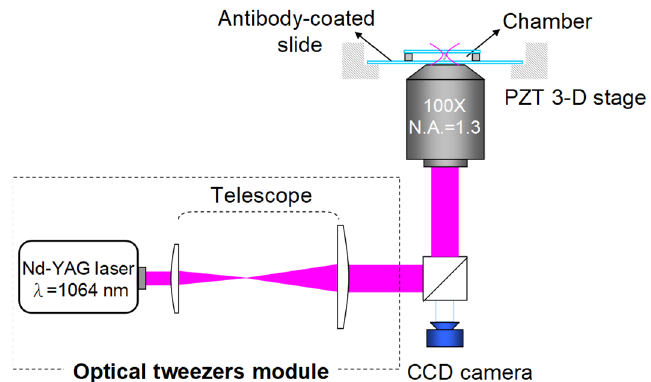
Figure 1. The schematic figures of the OT and the sample chamber.